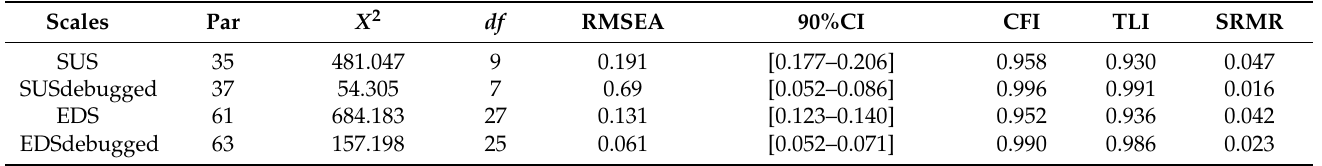
Table 2. Fit indexes for